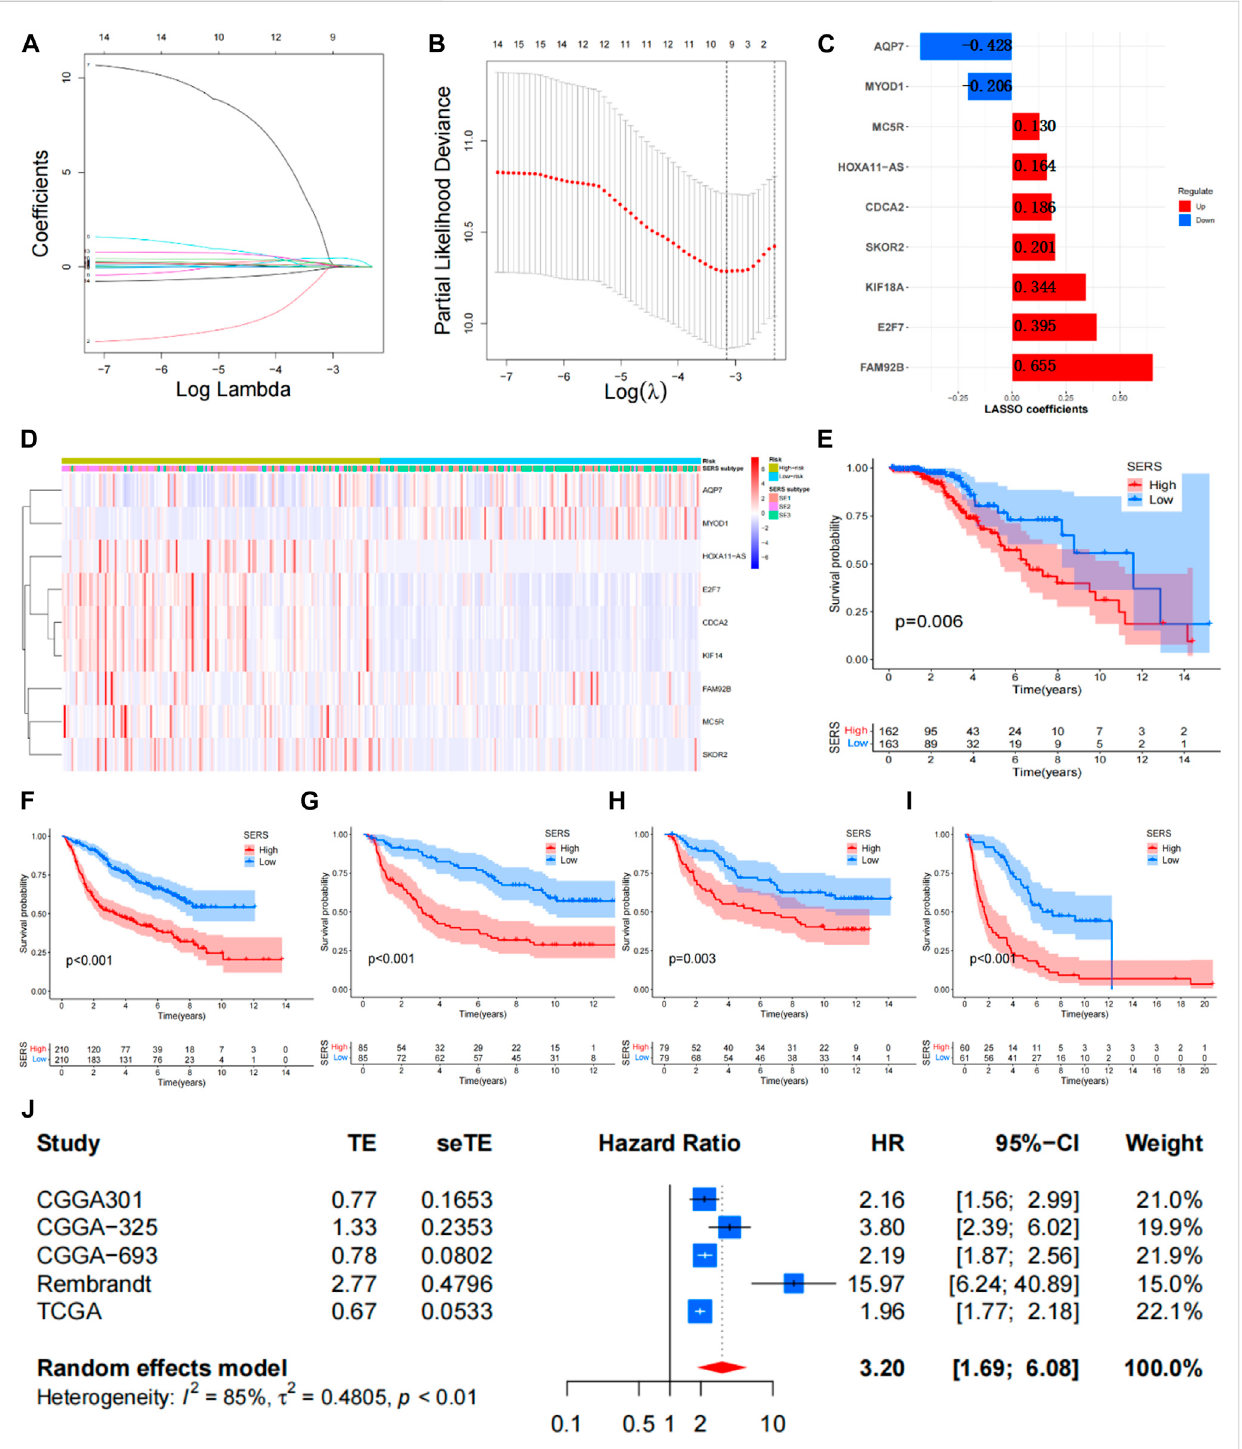
FIGURE 3 Construction of the SERS for LGG patients. (A,B) The LASSO regression was performed to minimize the risk of over fi tting with the minimum criteria. (C) LASSO coef fi cients of selected the SERS. (D) Heatmap was represented expression levels of 8 SE-related genes in the high- and low-risk groups, respectively. (E – I) The Kaplan – Meier survival curves of SERS in TCGA, CGGA693, CGGA325, CGGA301, and Rembrandt cohorts, respectively. (J) Meta- analysis with random_effects showed a pooled hazard ratio (HR) of